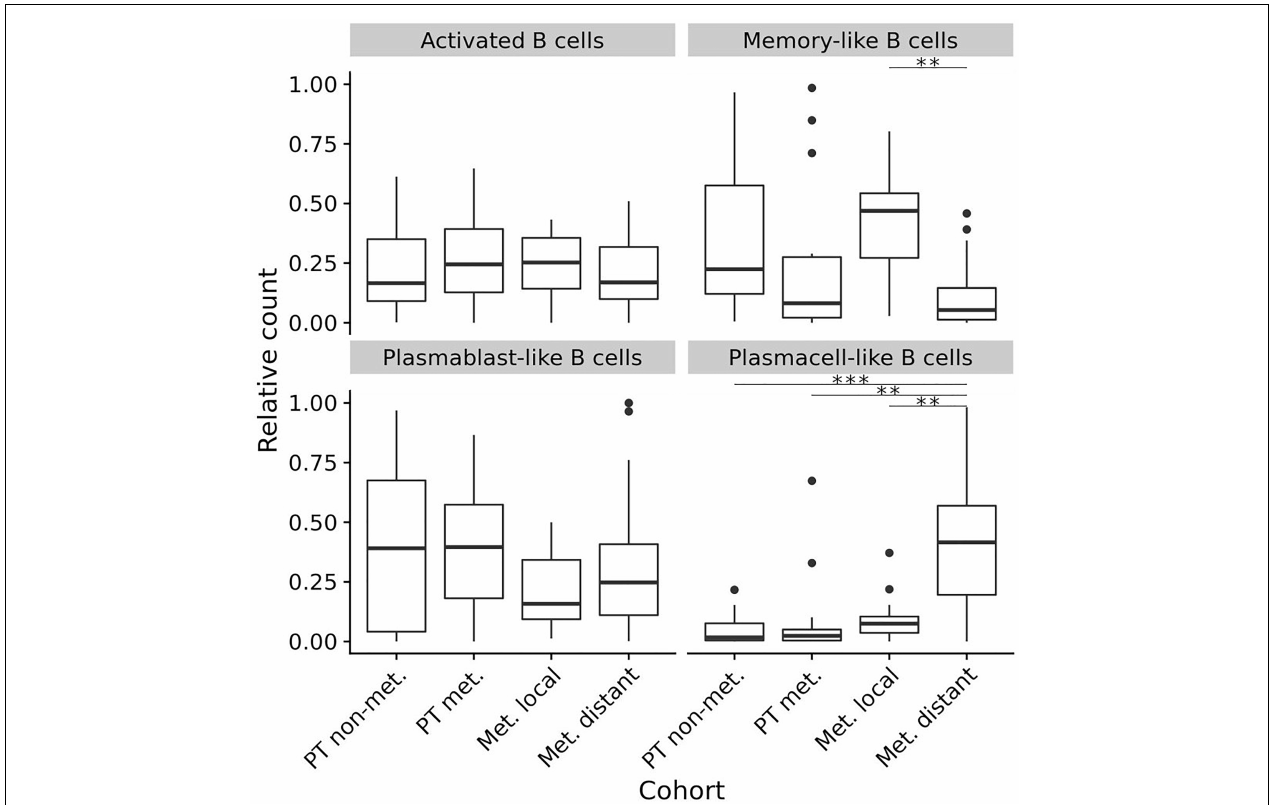
FIGURE 4 | Composition (relative frequencies) of four different TAB and ASC subpopulations in different stages of human melanoma disease. Box plots comparing primary tumors that did not metastasize (PT non-met., n = 22) with primary tumors that metastasized (PT met., n = 14), early locoregional metastatic sites (Met. local, n = 15) and late distant metastatic sites (Met. distant, n = 33). FDRs (adjusted) for memory-like TAB at early locoregional metastatic sites are 0.08 and 0.001 compared to primary tumors that metastasized and late distant metastatic sites, respectively. FDRs (adjusted) for plasma cell-like ASC at late distant metastatic sites are < 0.001 compared to primary tumors that did not metastasize, and 0.001 compared to both primary tumors that metastasized as well as early locoregional metastatic sites. In boxplots lower and upper hinges correspond to first and third quartiles and center lines to medians. Upper whiskers extend to the largest value within 1.5 times the interquartile range. Outliers are shown as black circles. ∗∗ p < 0.01, ∗∗∗ p <